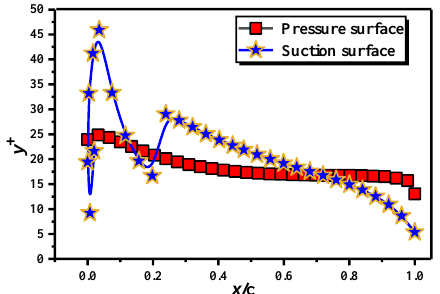
Experiment TCM Figure 7. Comparison between experiment and TCM. [26].